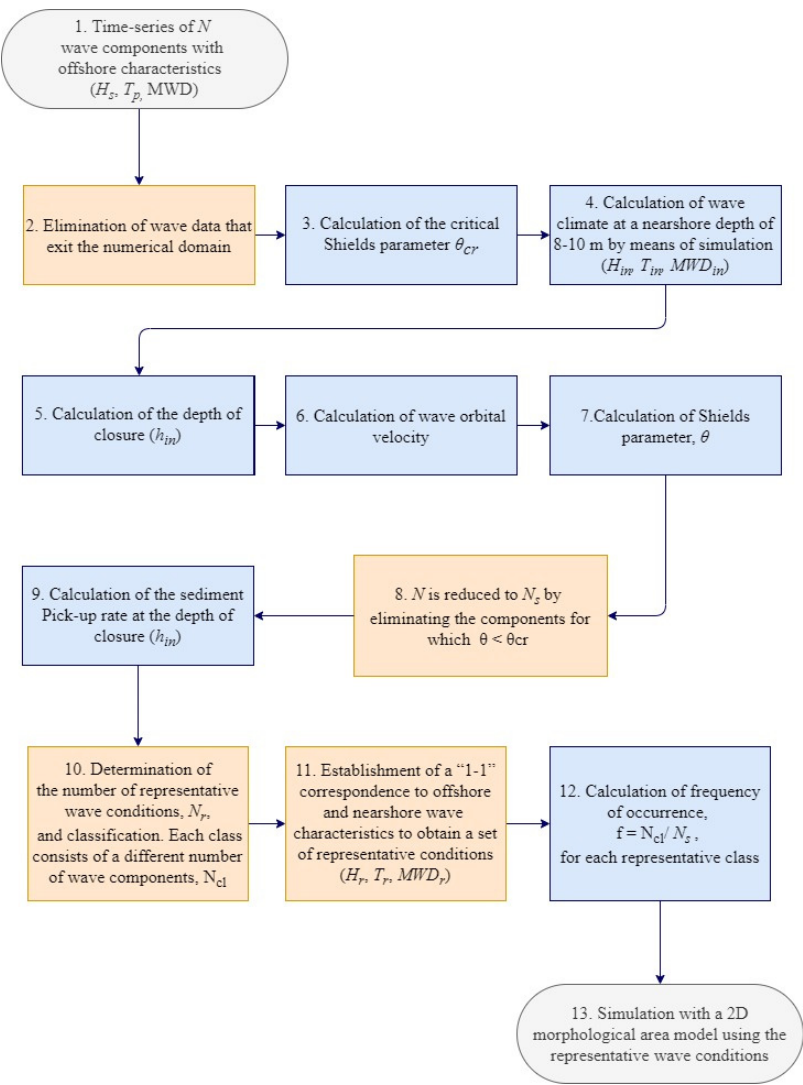
Figure 1. Flowchart of the proposed input-reduction method based on the sediment pick-up rate.